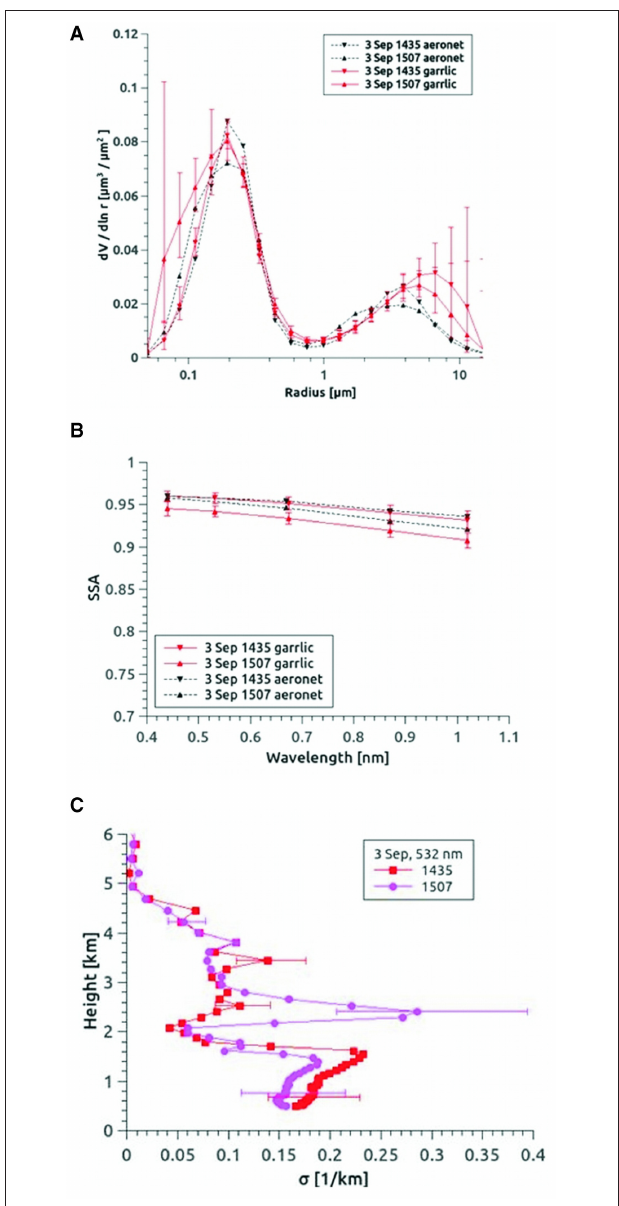
FIGURE 8 | Aerosol parameters from lidar and sun-photometer data of September 3: (A) size distribution, (B) single scattering albedo, (C) extinction profile. Lidar ratio at 532nm wavelength of each retrieved